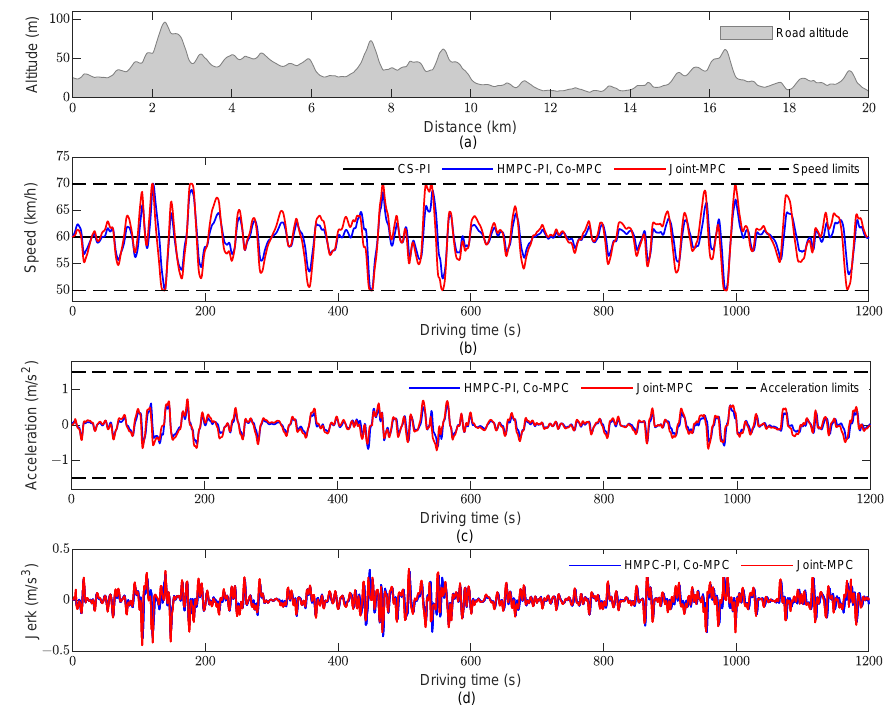
Figure 6. Speed results of the first case study. ( a ) Altitude profile of the expressway; ( b ) Speed trajectories for different methods; ( c ) Acceleration profiles of the co-MPC and joint MPC; ( d ) Jerk profiles of the co-MPC and joint MPC.